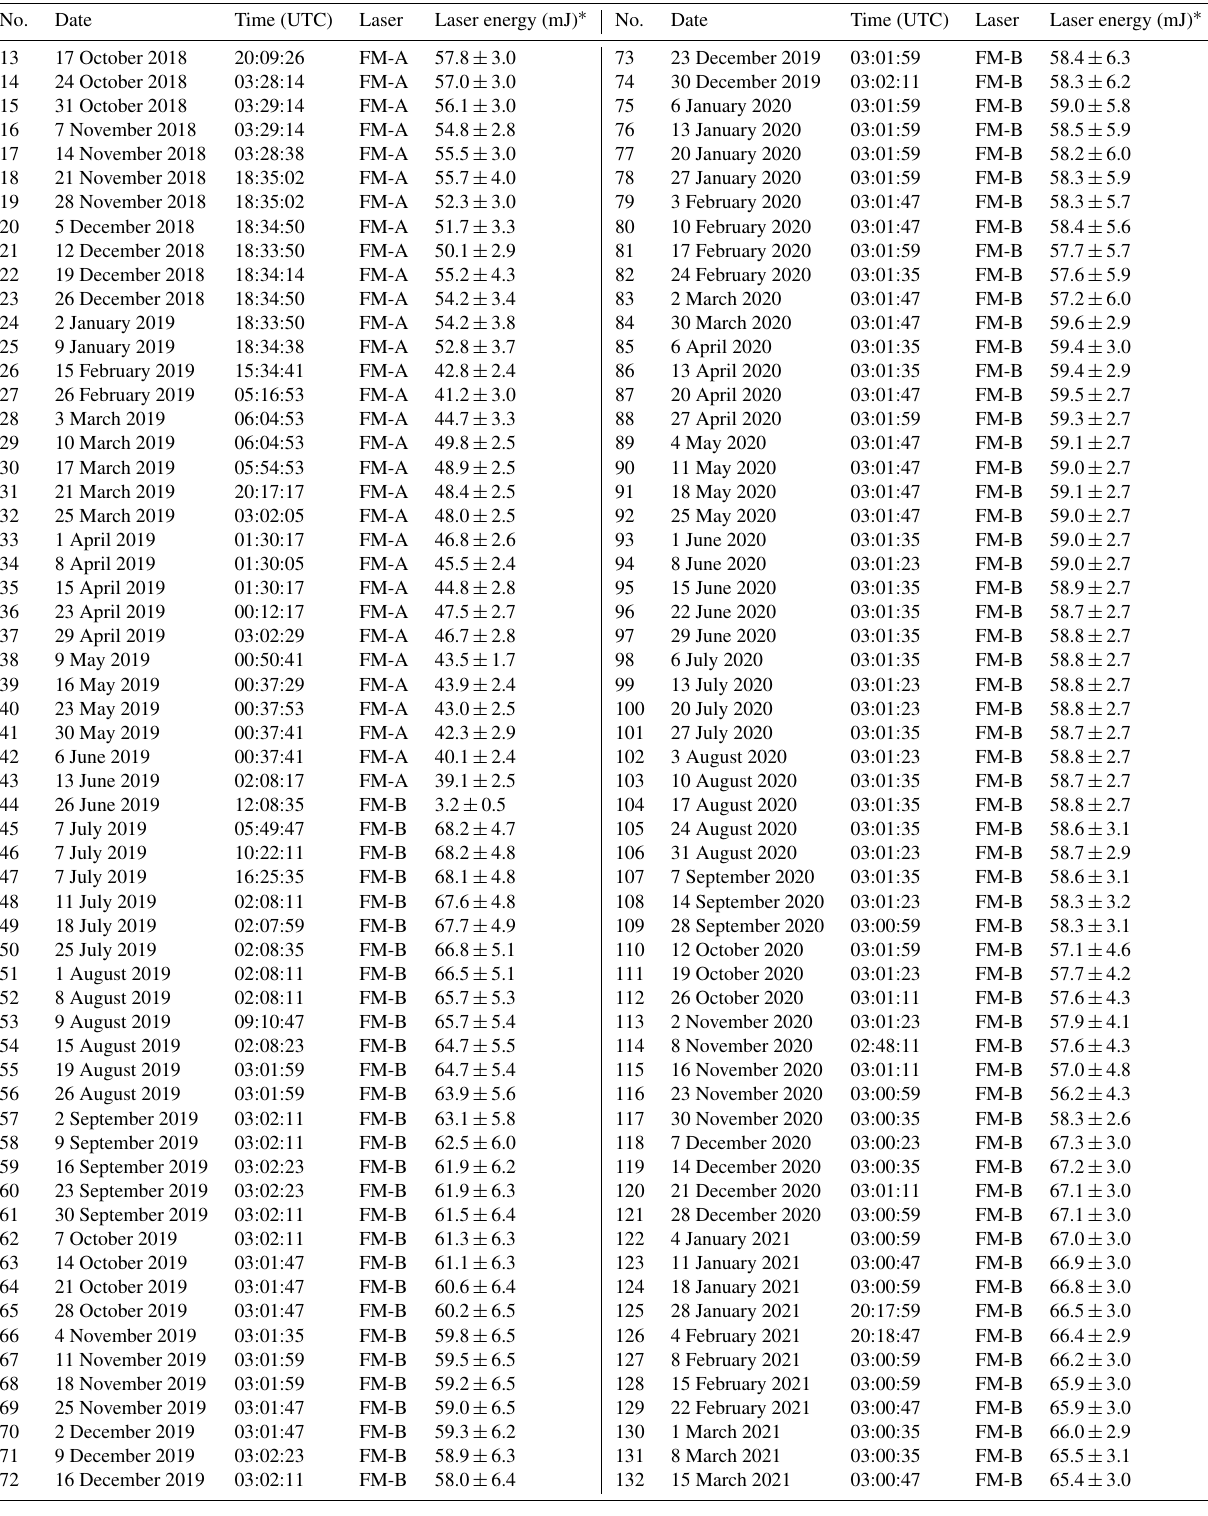
Table 2. Overview of the ISR data set used in this study.